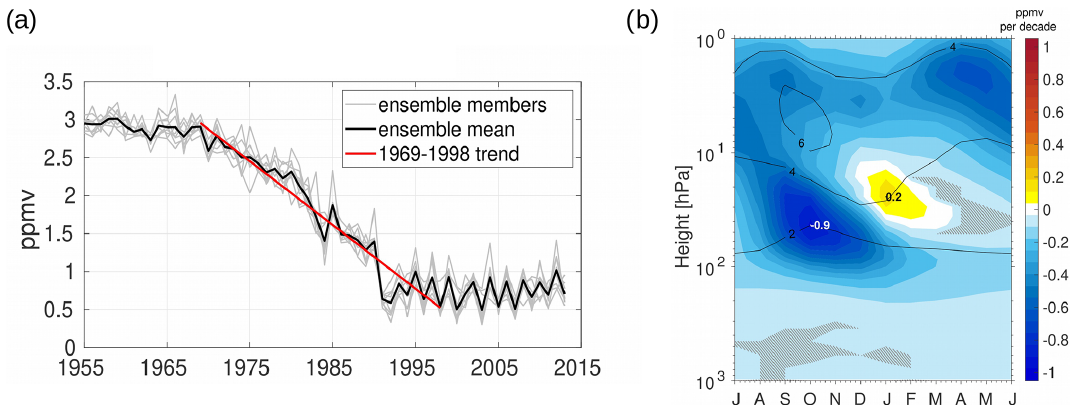
Figure 4. (a) Polar cap (65–90 ◦ S) ozone time series for October at 50hPa for the single ensemble members (gray) and the ensemble mean of Chem ON (black). The red line depicts the linear trend in ozone from 1969 to 1998 in Chem ON. Please note that the ozone time series shown here for Chem ON is the same for Chem OFF and for Chem OFF 3D. (b) Polar cap (65–90 ◦ S) linear ozone trend in parts per million by volume per decade as function of height for the ensemble mean of Chem ON for the time period 1969–1998 (shading). The climatology in ozone (contours) is represented for the same period with an interval of 1ppmv. Statistically insignificant trends are hatched at the 5% level based on a Mann–Kendall